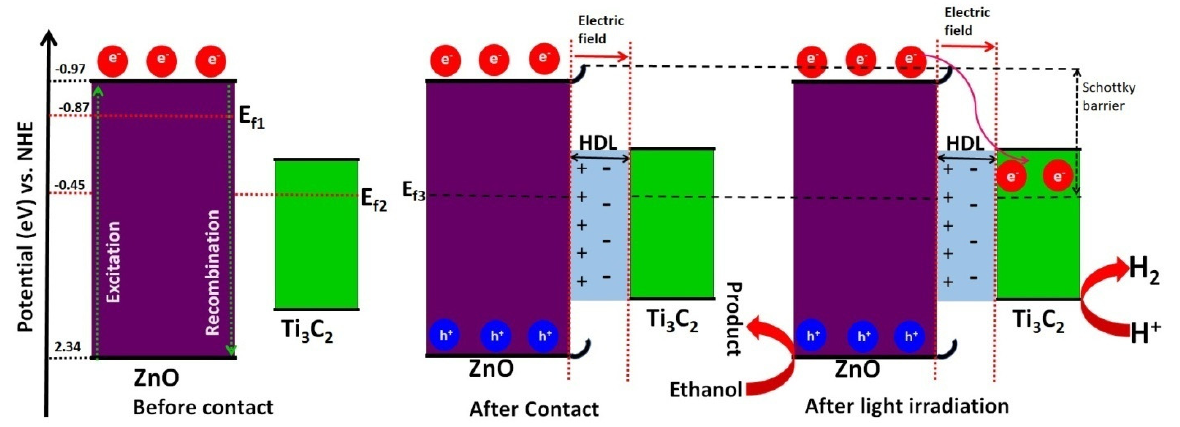
Figure 7. The mechanism of photocatalytic H 2 evolution activity over ZnO 0/7 /TiC 0/3 composite.